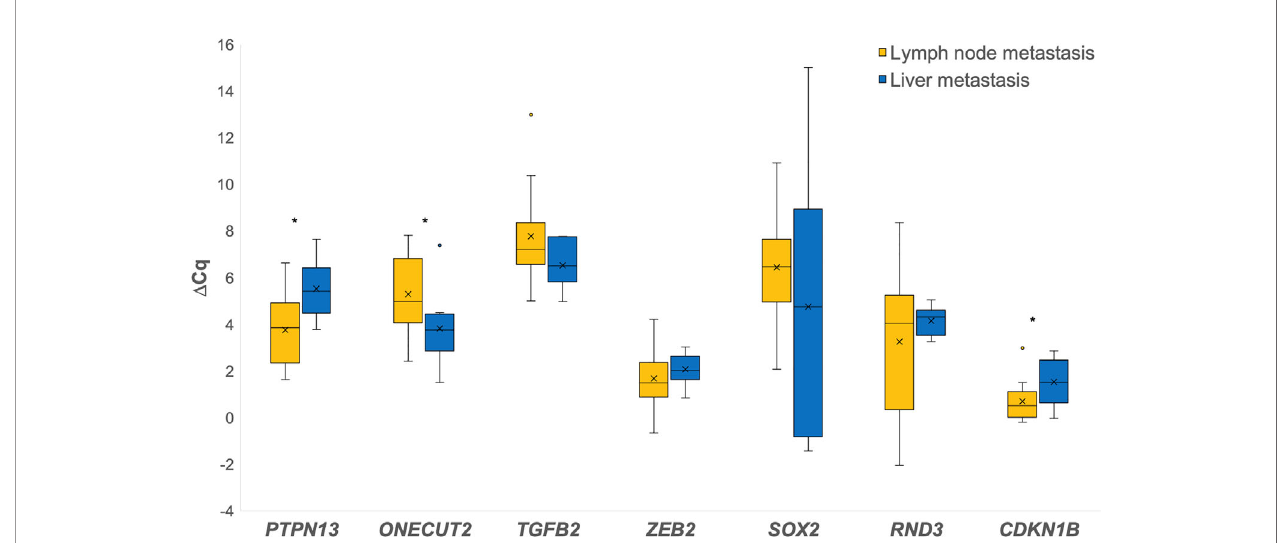
FIGURE 4 | Expression of the investigated genes in lymph node metastases in comparison to liver metastases. *p ≤ 0.05.